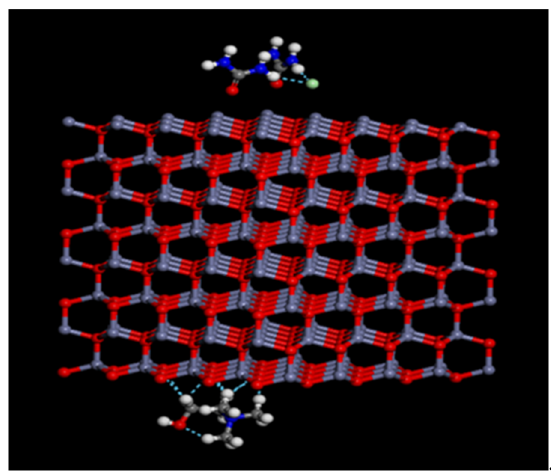
Figure 6. The adsorption structure of ZnO and ChCl ‐ 2Urea DES.